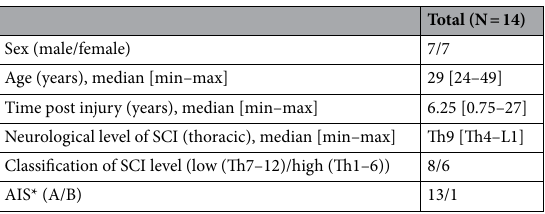
Table 2. Participant characteristics. *AIS = American Spinal Injury Association Impairment